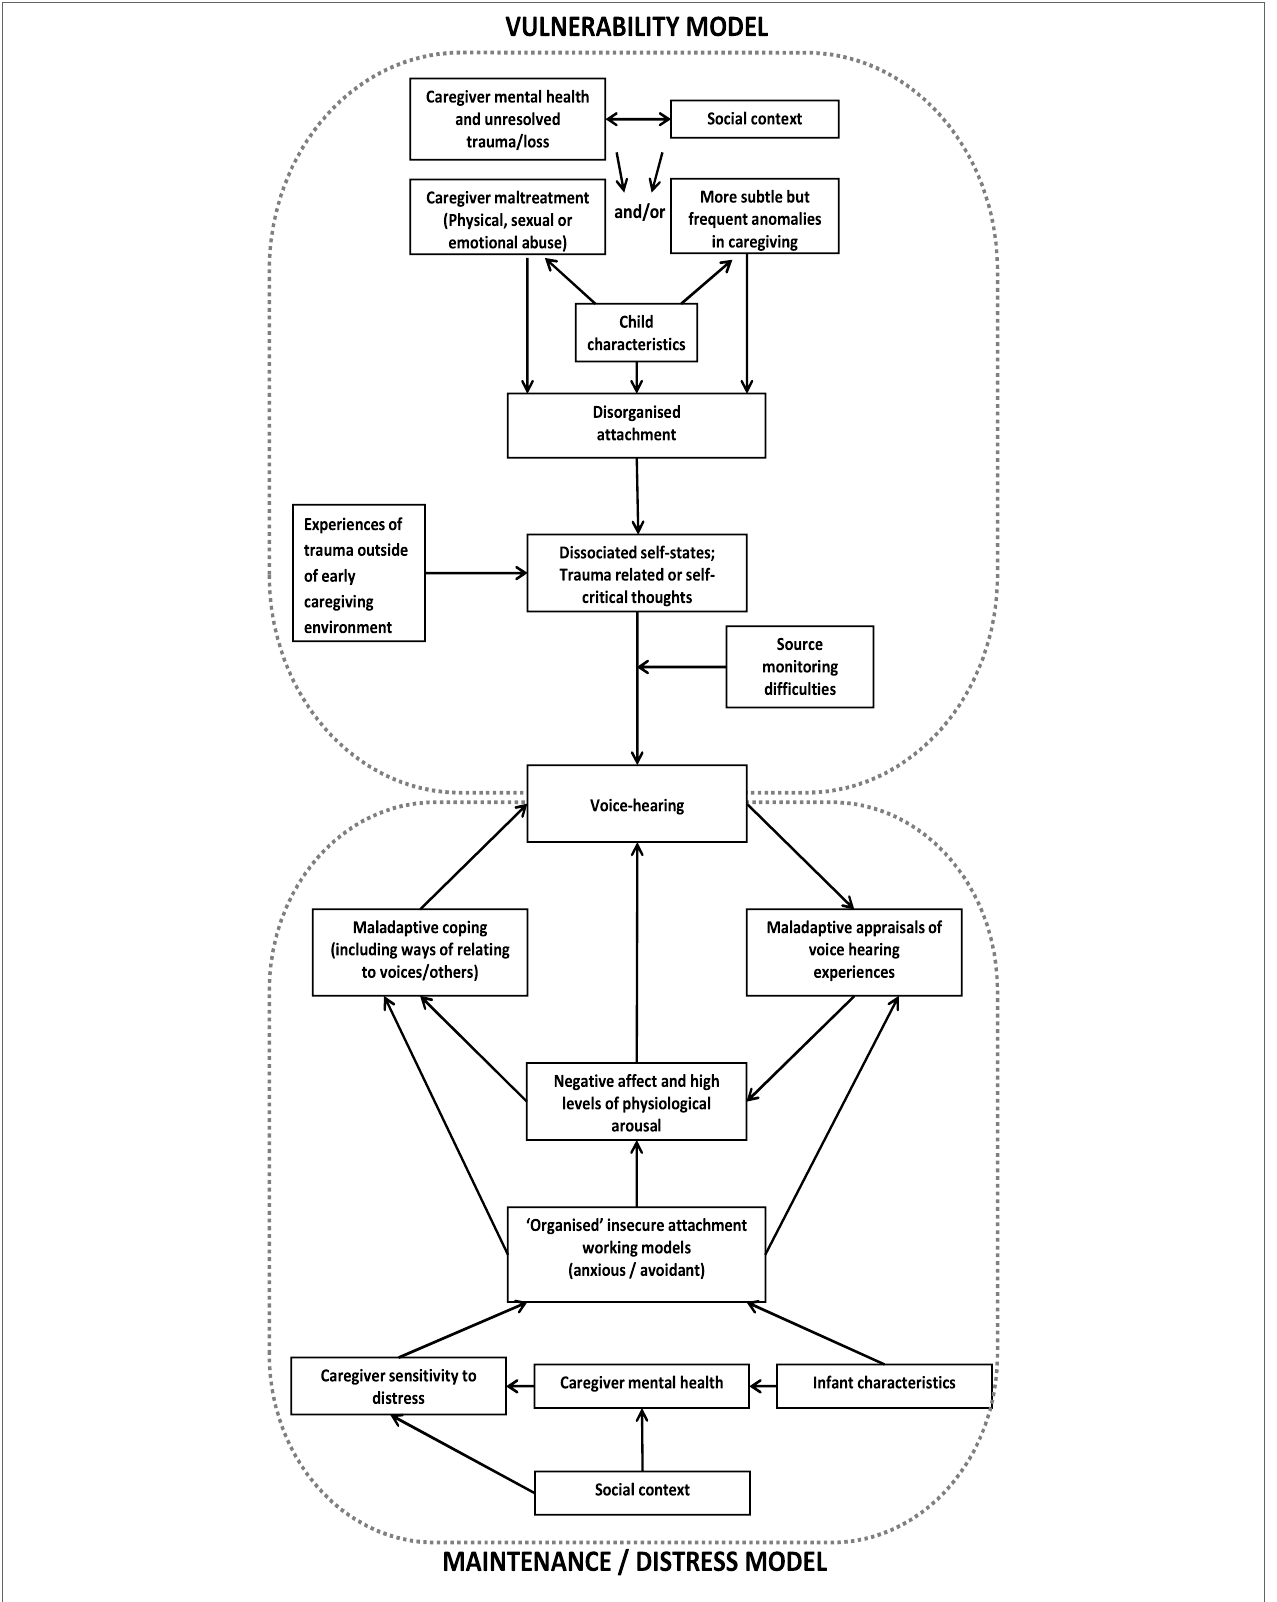
FigUre 1 | Graphical representation of the cognitive attachment voice-hearing model [adapted from Ref.